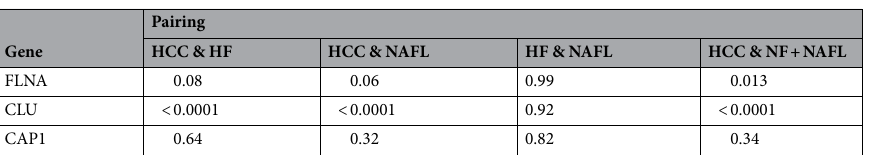
Pairing Gene HCC & HF HCC & NAFL HF & NAFL HCC & NF +